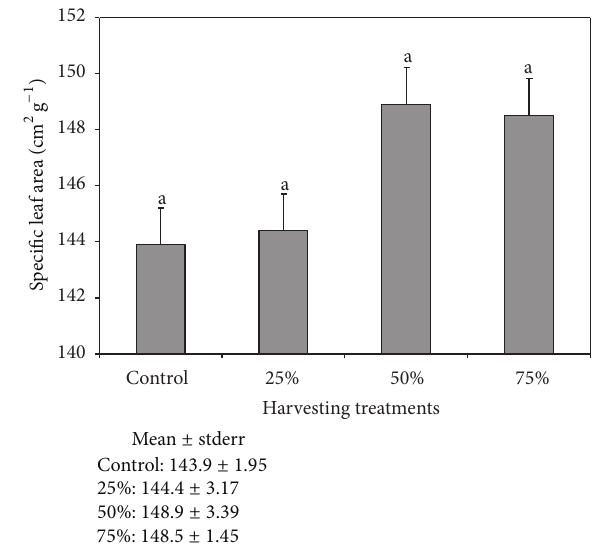
Figure 7: Specific leaf area response to T. daniellii foliage harvest intensity. Means ( ± SE) with similar letters do not differ significantly at 5% probability